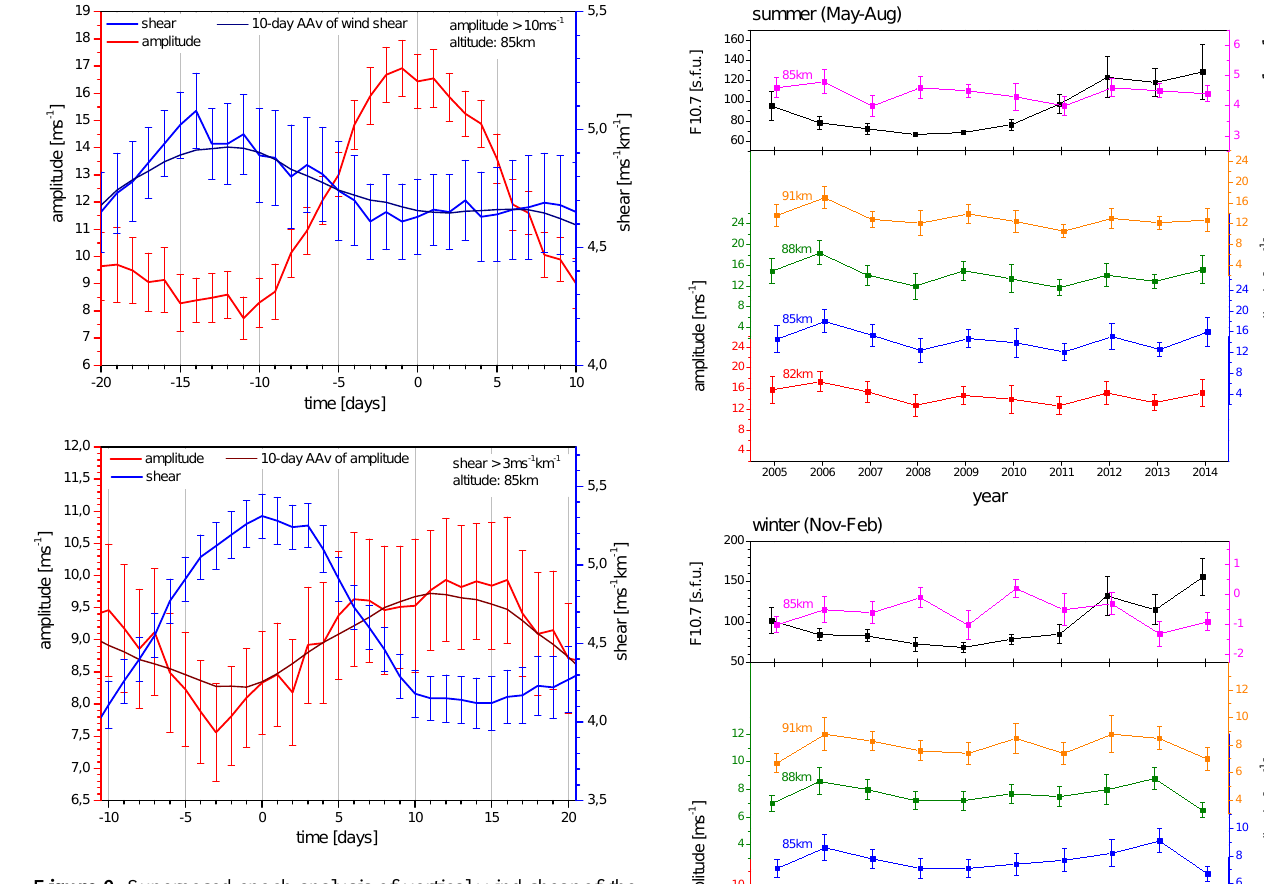
not significant. Correlation coefficients vary between − 0 .